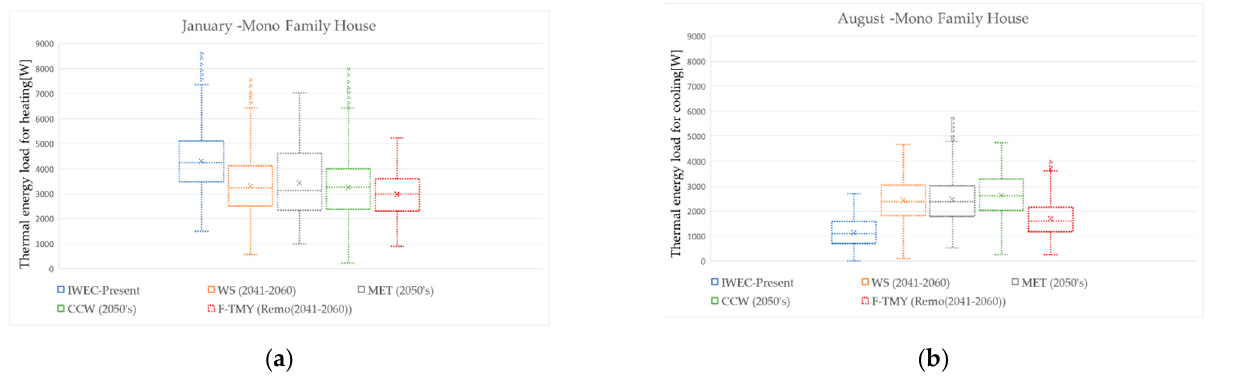
Figure 4. Boxplots of heating loads in January ( a ) and cooling loads in August ( b ) of the mono family house for IWEC (Present), Weathershift (WS), Meteonorm (MET), CCWorldWeatehr-Gen (CCW), and F-TMY. All future weather files are for 2050s considering RCP 8.5.